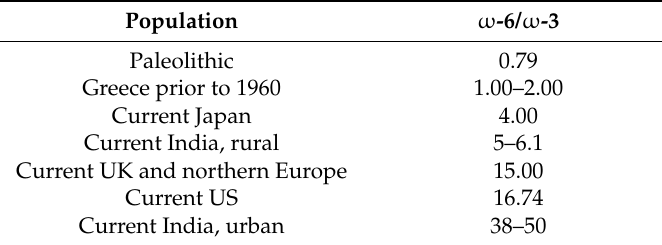
Table 4. Omega-6/Omega-3 Ratios in Different